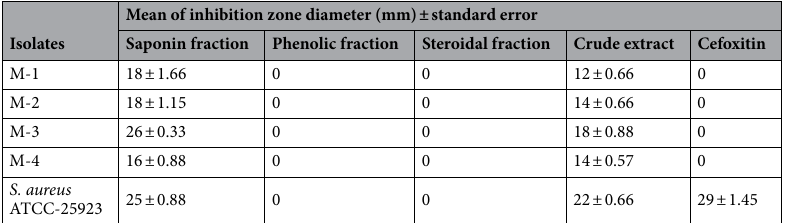
Table 3. Antibacterial activity of Zygophyllum album crude extract and its fractions.